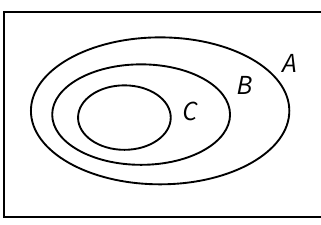
Figure 1. The formal structure of